Question: Briefly state, in one sentence, what is plotted here.
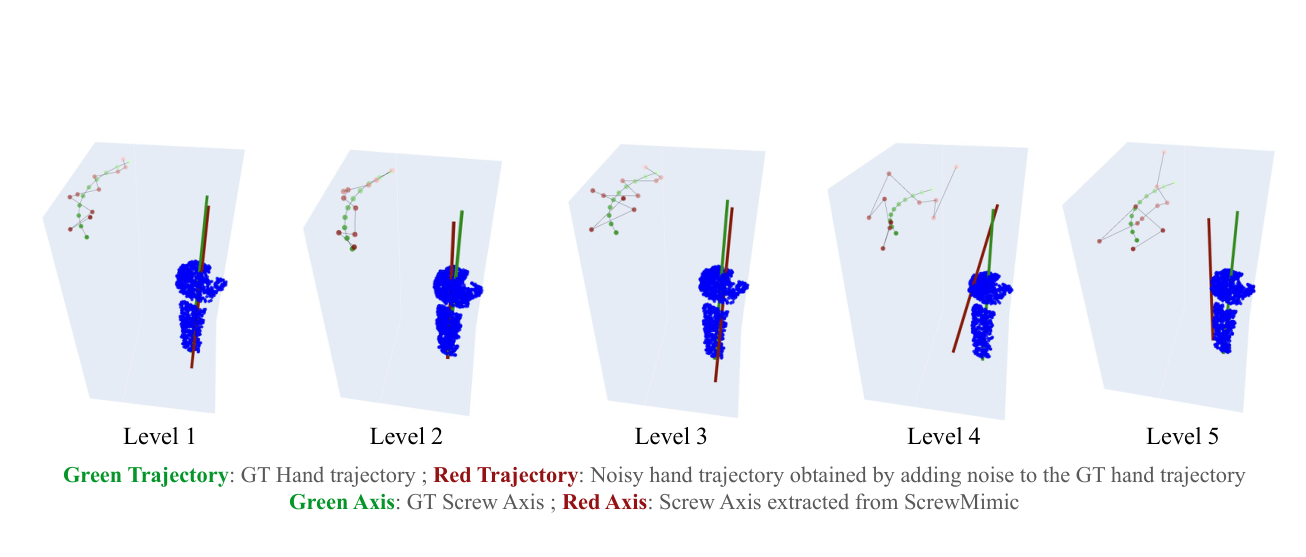
Answer: ScrewMimic’s axis extraction with increasingly noisy demonstrations. The five levels represent increasing noise applied to the ground truth hand trajectory (position and orientation). Comparing each screw axis with the ground truth screw axis in this figure and the numbers in Tab. VII, and performing the fine-tuning experiment with the axis inferred from the highest noise level, we observe that although ScrewMimic does suffer from increasing noise in the hand trajectories, it is able to extract an axis sufficiently accurate for fine-tuning.